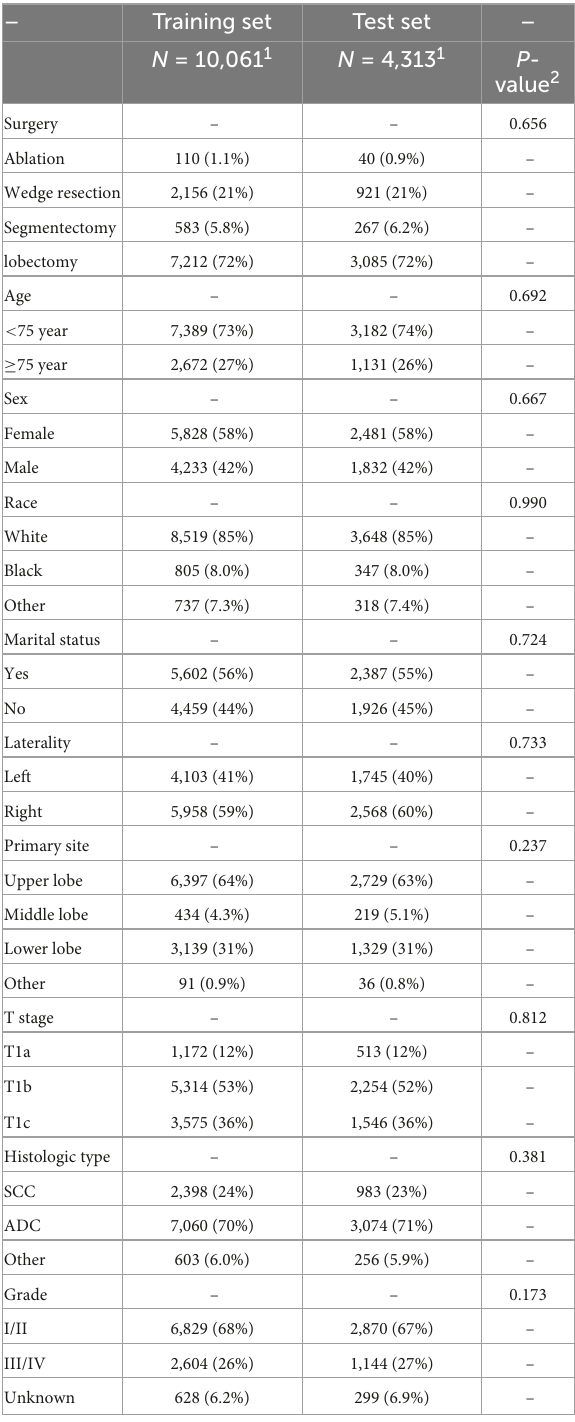
TABLE 3 Univariate and multivariate Cox regression of OS in stage IA NSCLC